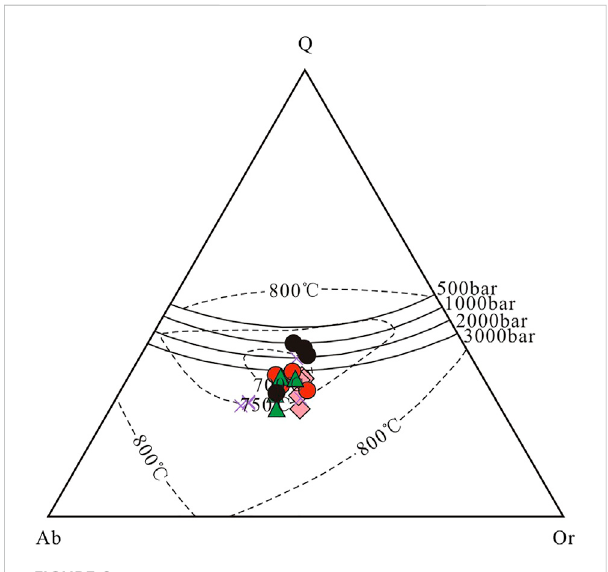
FIGURE 8 Q-Ab-Or-H 2 O diagram (adapted from Chen et al., 2005) for the granite in Chuhuertu. Symbols are the same as in Figure 4.